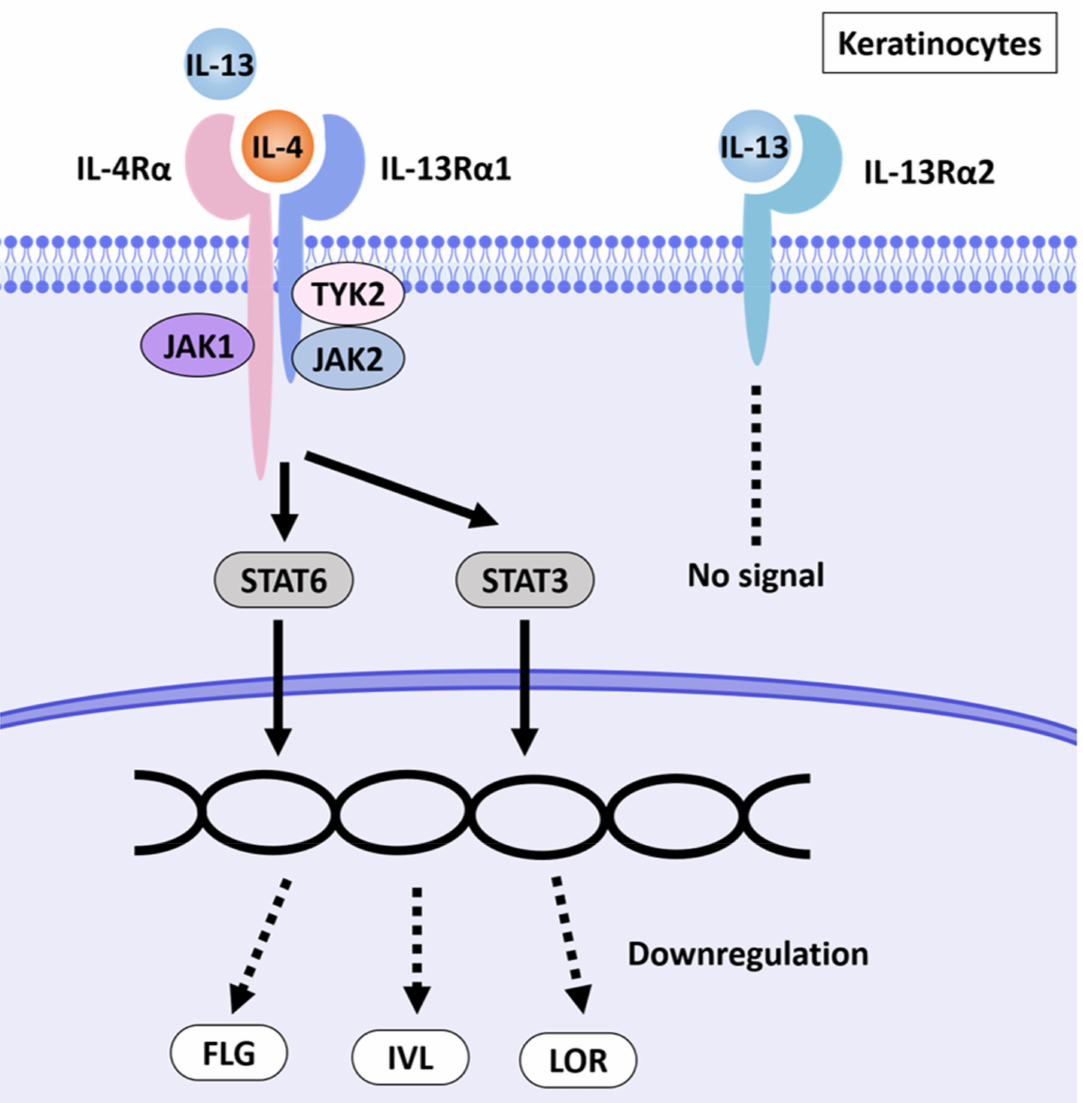
Figure 1. Schematic illustration of AD pathways induced by IL-4 and IL-13. IL-4 and IL-13 have partly shared receptor systems. Corneocytes express the IL-4R α /IL-13R α 1 complex. IL-4 and IL-13 share IL-4R α /IL-13R α 1 in NHEKs, activate the JAK1/JAK2/TYK2-STAT6 and -STAT3 pathways and inhibit the expression of EDC molecules such as FLG, LOR and IVL. NHEKs also express IL- 13R α 2, a prey receptor for IL-13. IL-13R α 2 binds to IL-13 with high affinity but does not transmit a signal